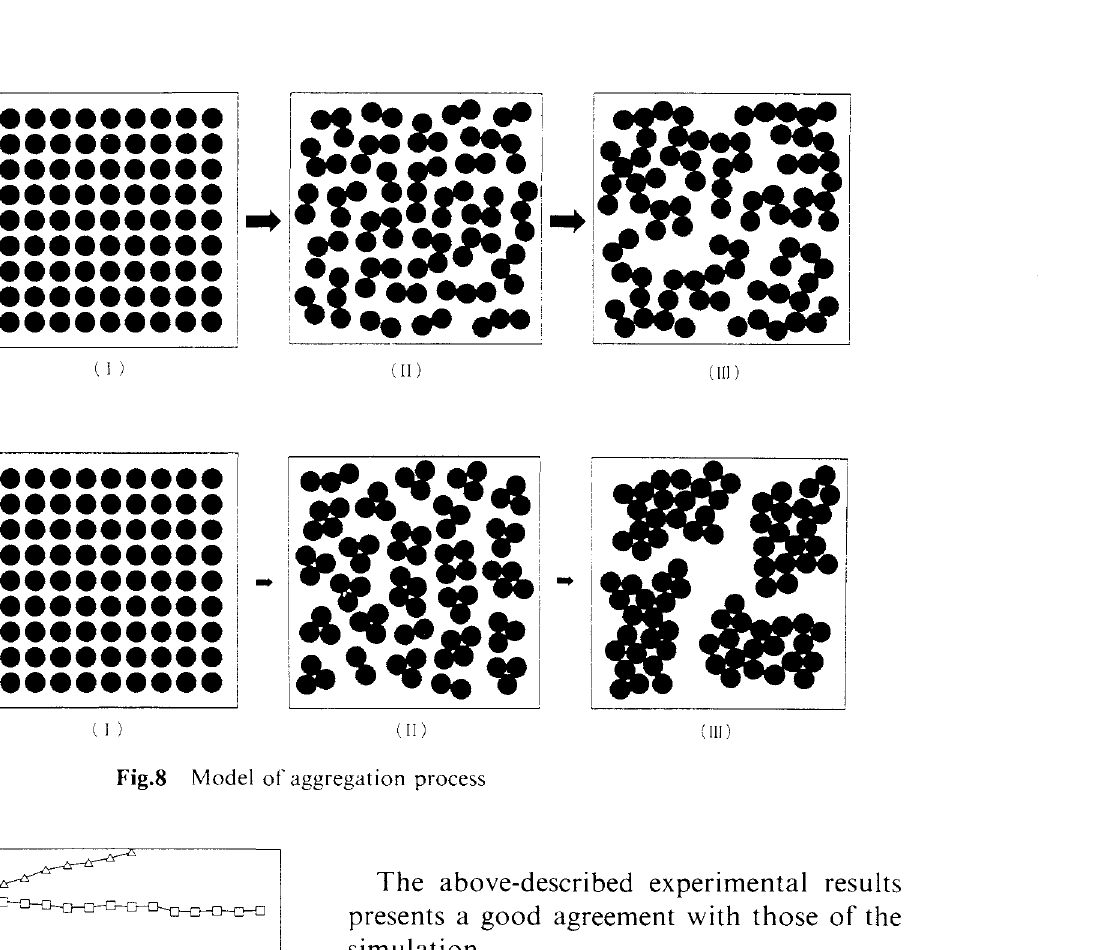
Fig.8 Model of aggregation process